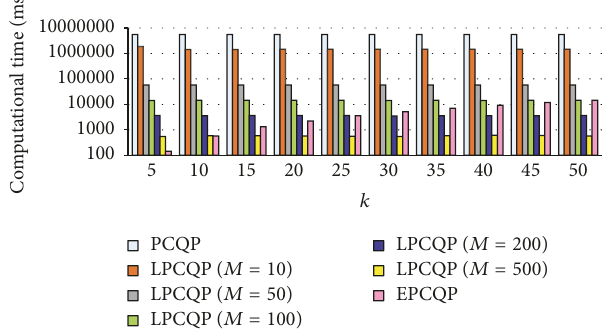
Figure 11: Computational time for the shifting process.